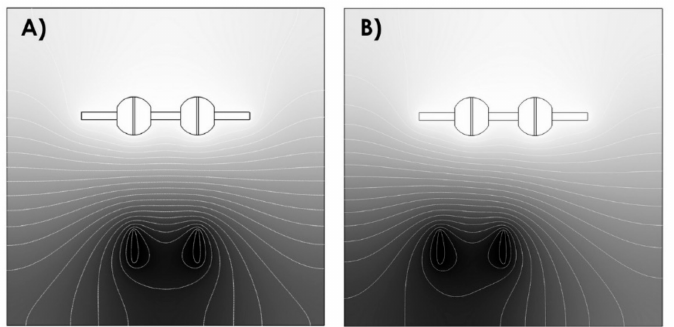
Figure 2. Results of numerical simulations of the distribution of electrostatic field intensities for a symmetrical arrangement ( A ) and for spinning jets at the left end of their path ( B